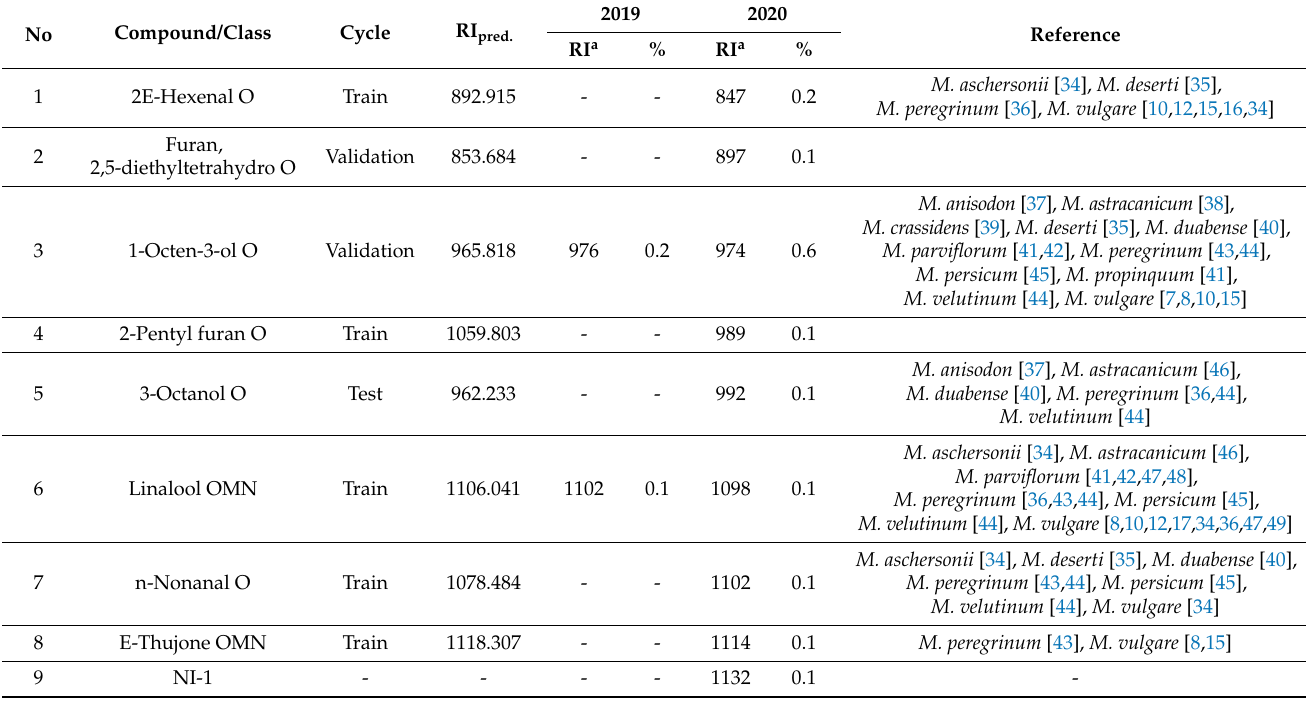
Table 1. Chemical composition of Marrubium vulgare during two years (2019 and 2020). No Compound/Class Cycle RI